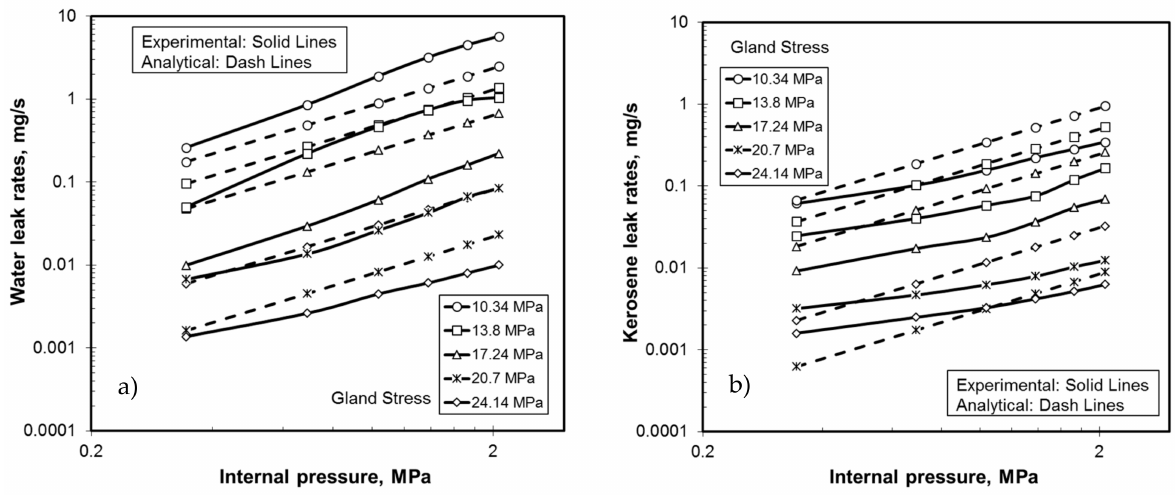
Figure 8. Leak rate predictions in flexible graphite packing ( a ) water ( b ) kerosene.